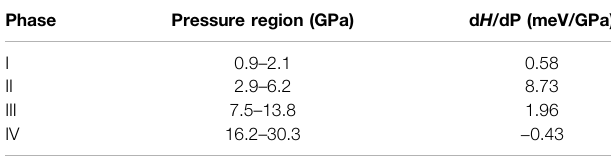
TABLE 1 | Calculated pressure dependence of the bulk activation energy. Phase